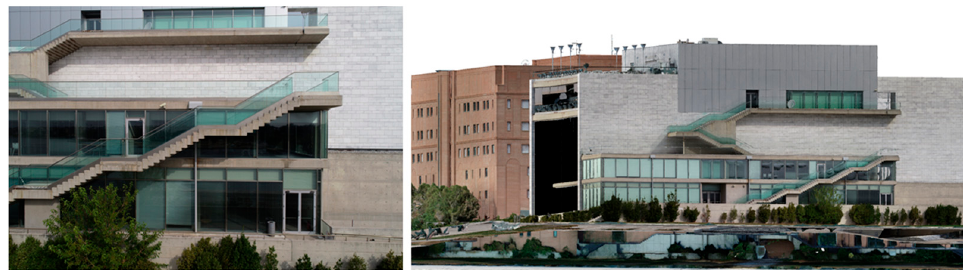
Figure 4. On the ( left ) we have a real image of a specific place, while on the ( right ) we have a screenshot from the corresponding 3D model that depicts a similar view as the real image with similar visual characteristics. The image sentiment analysis algorithm produces a “positive” result for valence for both images.